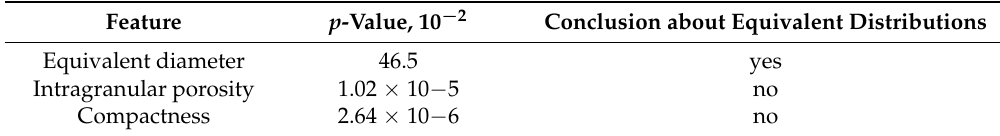
Table 2. Kolmogorov–Smirnov two-sample test for features of survived and crushed particles.